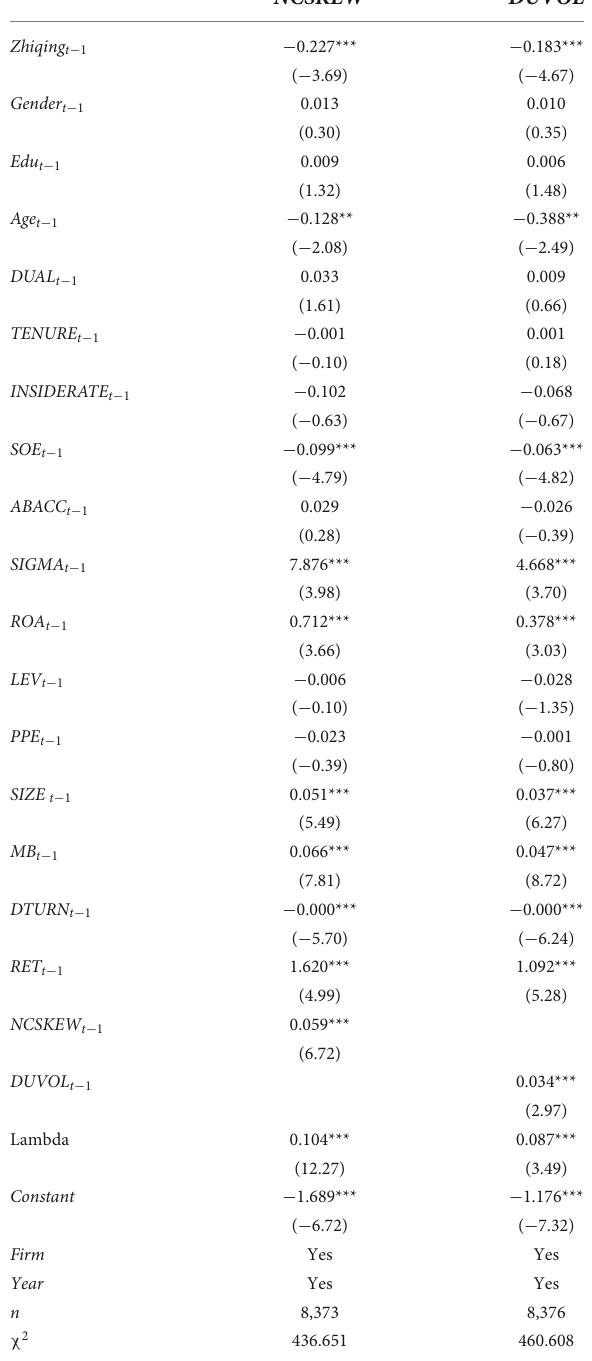
TABLE 8 Empirical results of the two-stage treatment effect model. NCSKEW